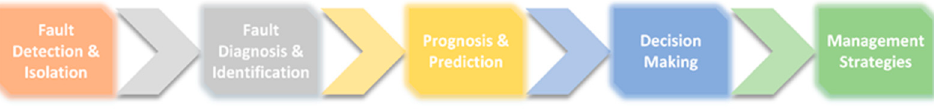
Figure 1. Basic tasks involved in a typical PHM system.